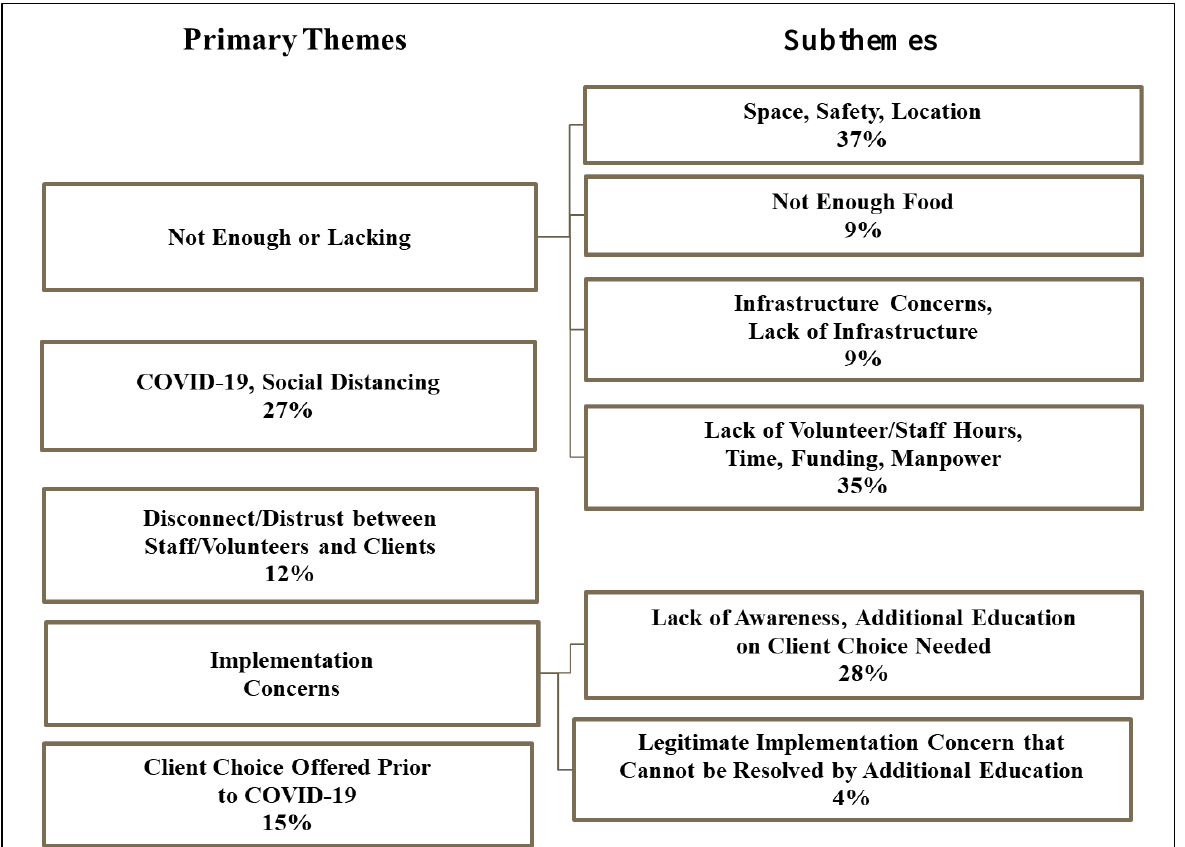
Figure 1. Themes and Subthemes Identified from Open-Ended Responses, with Percentages ( n